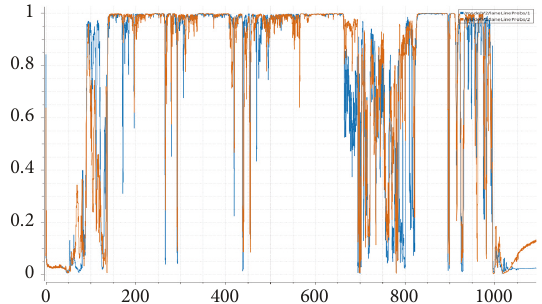
Figure 17: T1D4 left (1) and right (2) lane recognition.